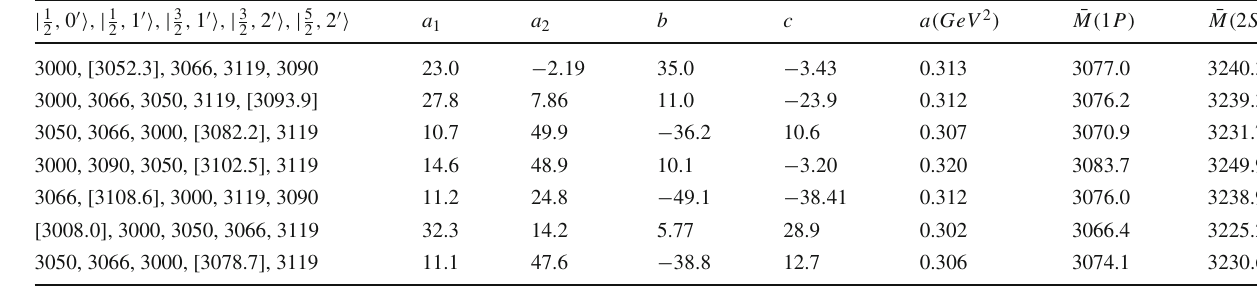
massinputsconsidered,withthemasspredictionatunseenlevelmarked by square bracket. The shown also includes the ensuing prediction for the Regge slope a (see text, in GeV 2 ) and spin-averaged 2S-wave mass (in MeV) of the c ( ss ) system. m ss = 991